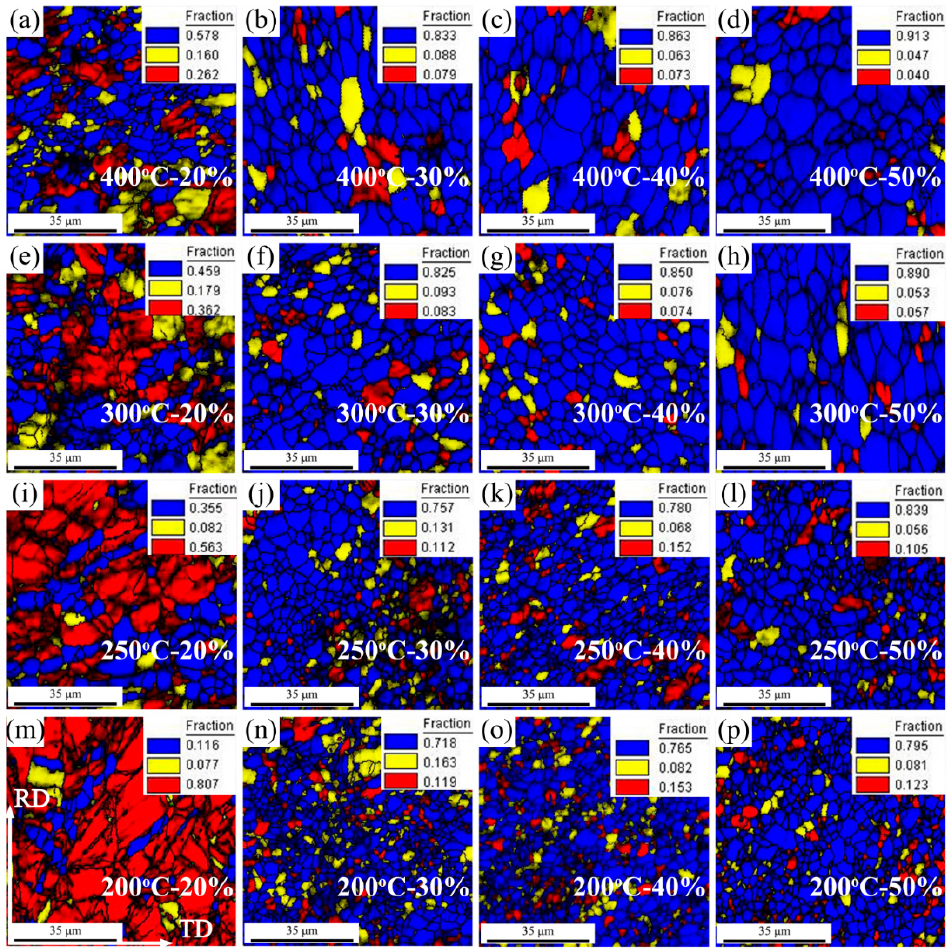
Figure 5. Microstructure characteristic maps of DRXed grains, subgrains, and deformed grains of AZ31 magnesium alloy sheets under different rolling process parameters: ( a ) 400 °C—20%, ( b ) 400 °C—30%, ( c ) 400 °C—40%, ( d ) 400 °C—50%, ( e ) 300 °C—20%, ( f ) 300 °C—30%, ( g ) 300 °C—40%, ( h )